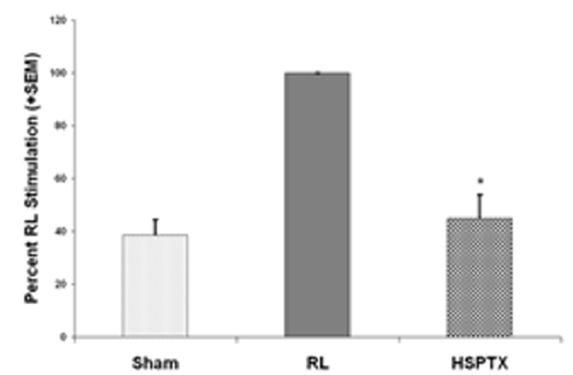
Figure 6 - Resuscitation-induced Lung Interleukin-8 Levels. Animals resus- citated with RL had increased concentrations of IL-8 in the lung. Resuscita- tion with HSPTX led to a 55% attenuation of IL-8. The graph presents mean BALF IL-8 levels of all animals studied in each group. *, p < 0.0001 vs.